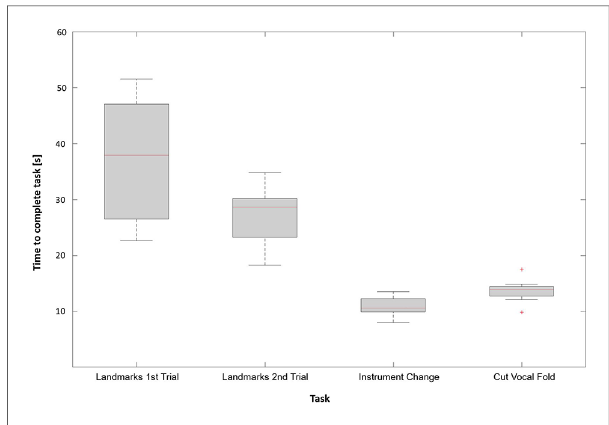
FIGURE 5 Time required by the participants to complete each task.